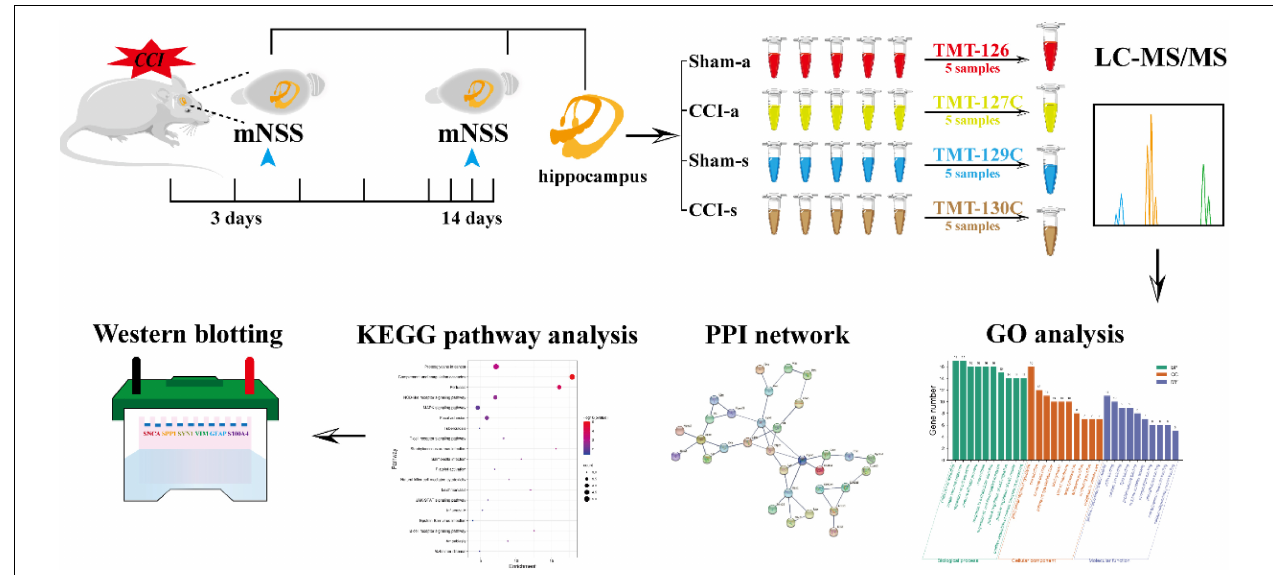
FIGURE 1 | The schematic flowchart of the study. Rats were randomly divided into sham and CCI groups. The mNSS was evaluated at 3 and 14 days. The hippocampal tissues of brains at 3 and 14 days were collected for proteomics. Data were processed with LC-MS/MS and analyzed by bioinformatics. Finally, WB further validated the results of